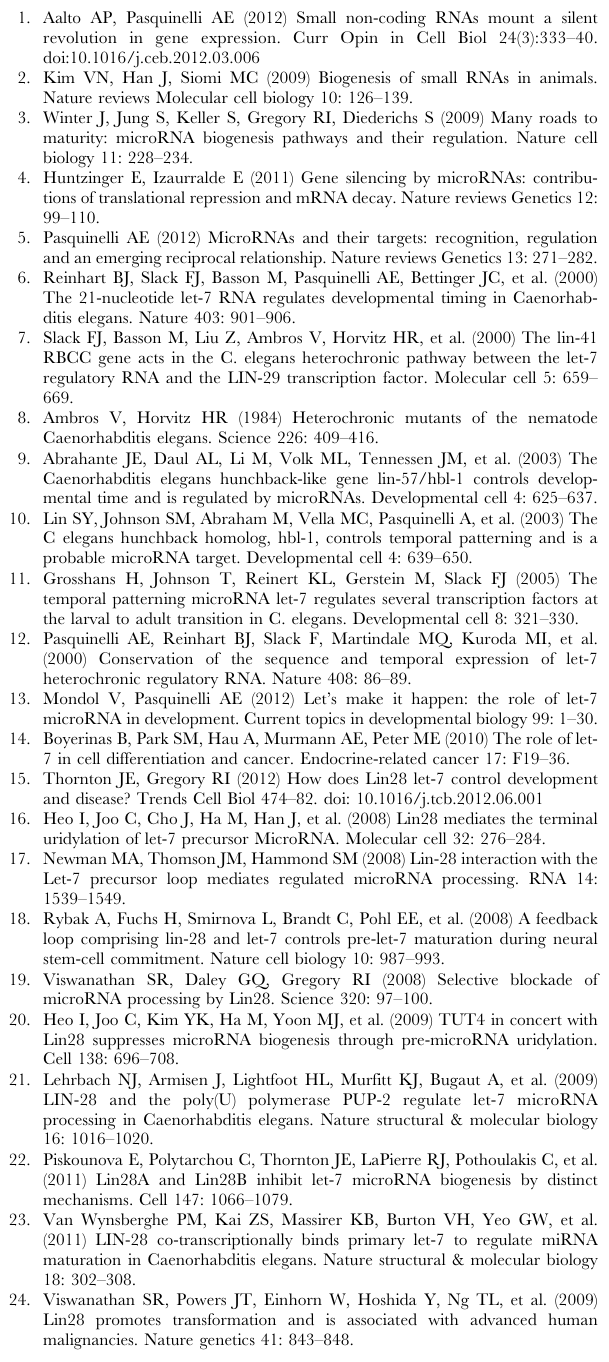
Table S4 List of primer sequences used in this study.